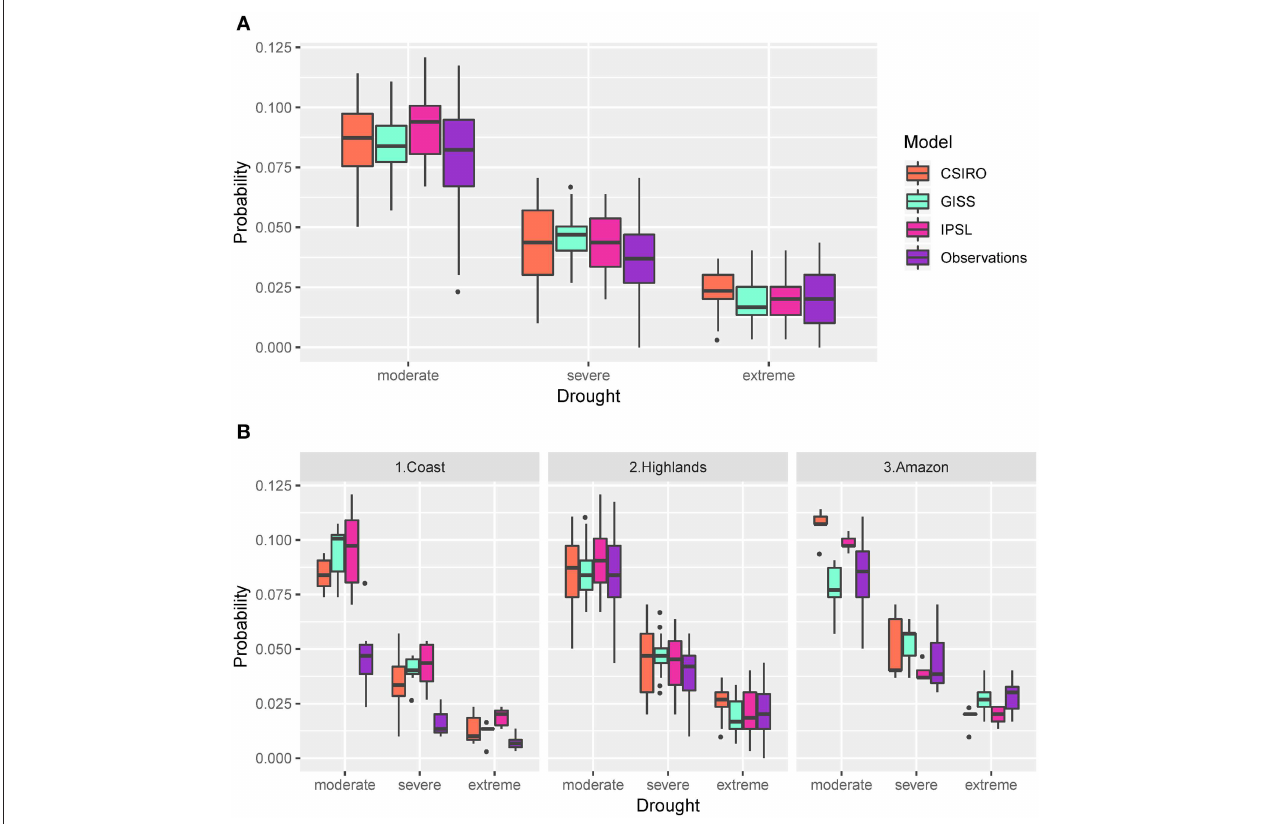
FIGURE 2 | Present time probability of drought occurrence by category for observations and DGCMs evaluated at ground stations. (A) for the whole country, (B) for each region.